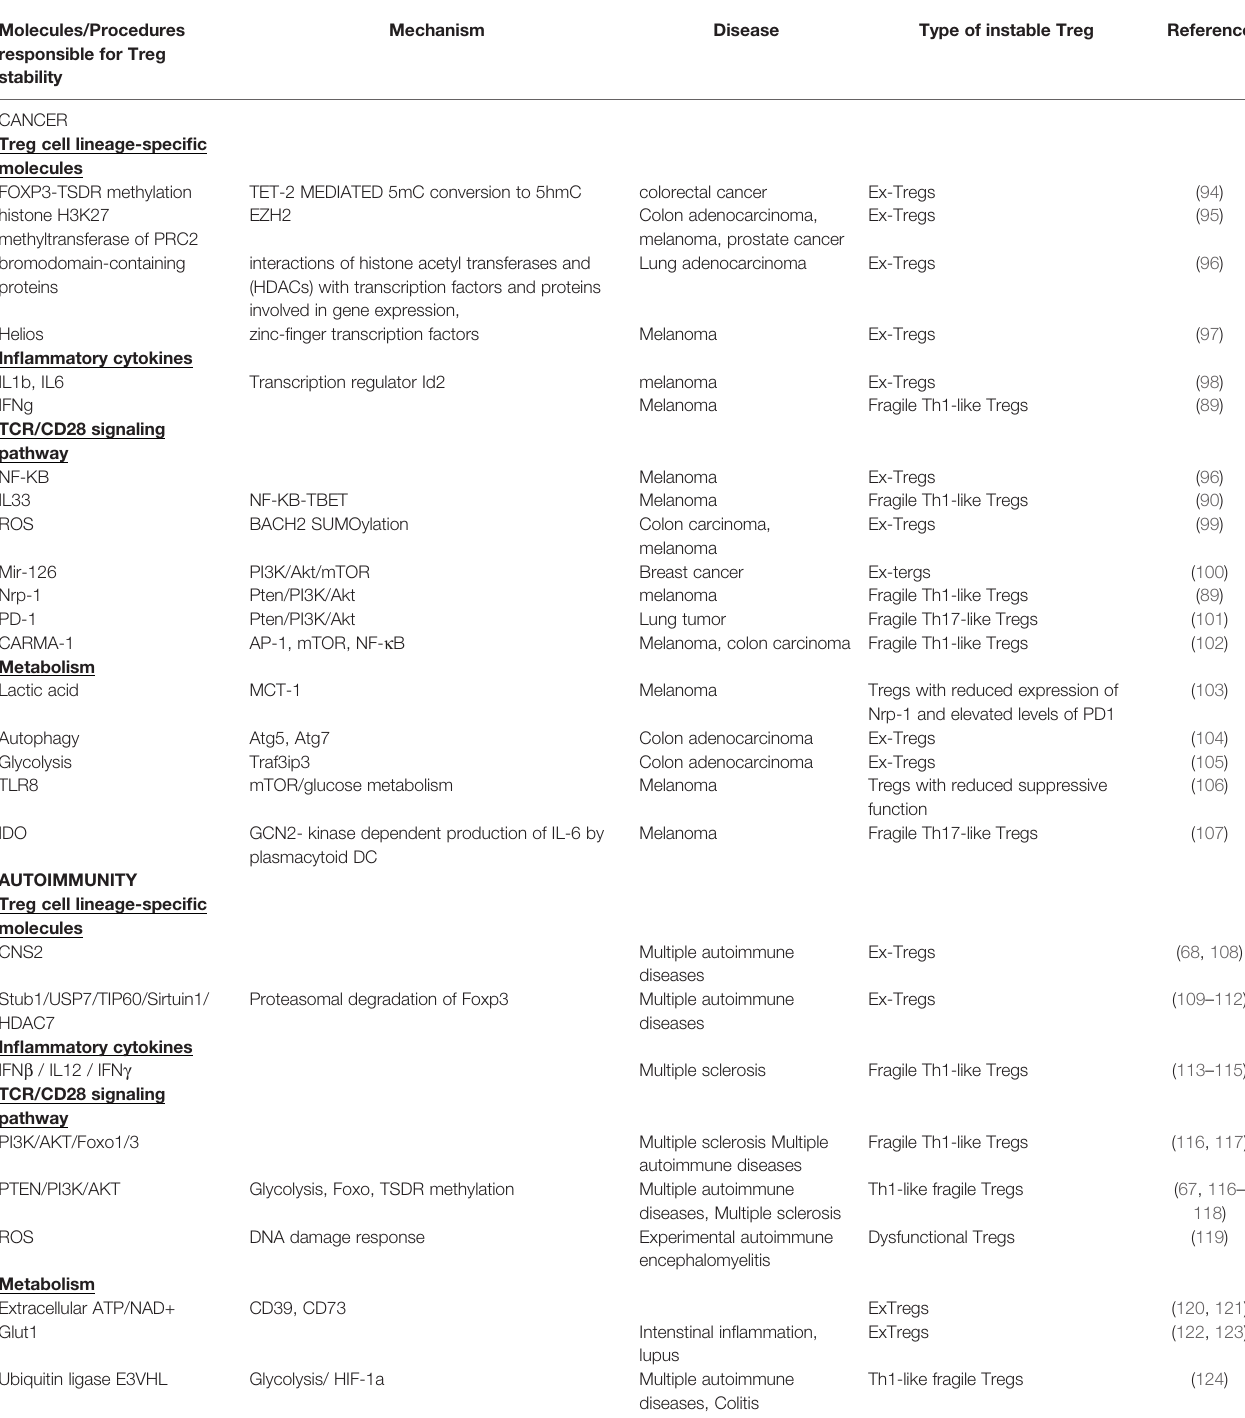
TABLE 1 | Molecules and mechanisms involved in Treg cell stability in cancer and